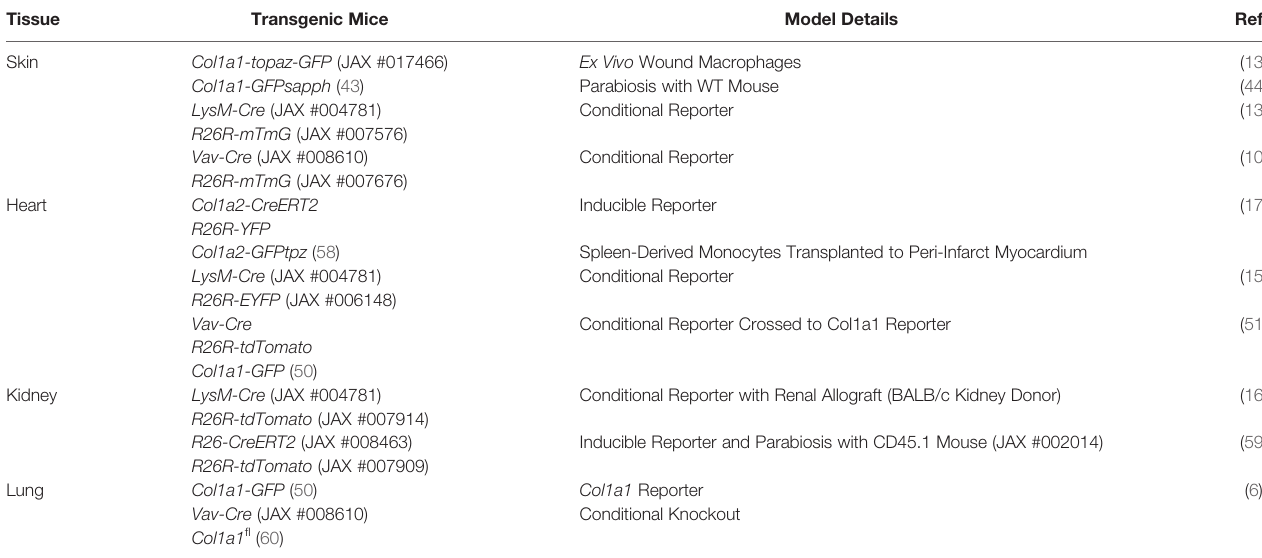
TABLE 3 | Other transgenic mouse